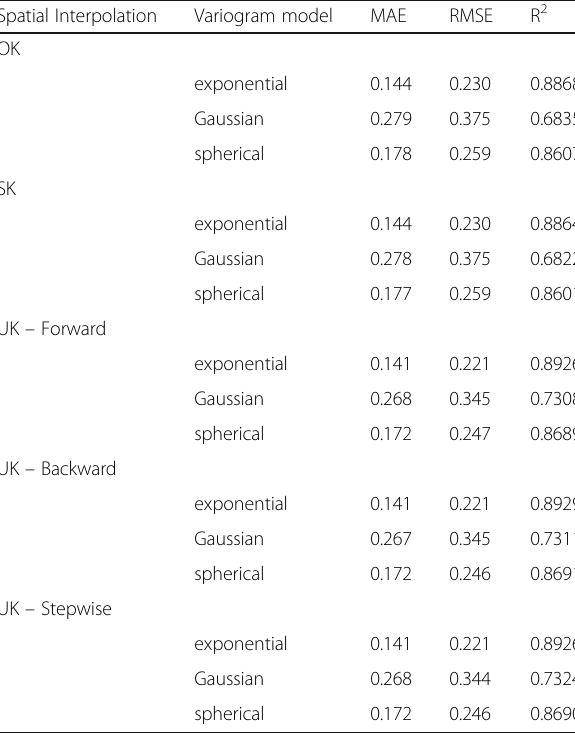
Table 7 Cross validation of OK, SK, and UK applying exponential, Gaussian, and spherical variogram models applied to Silt texture fraction Spatial Interpolation